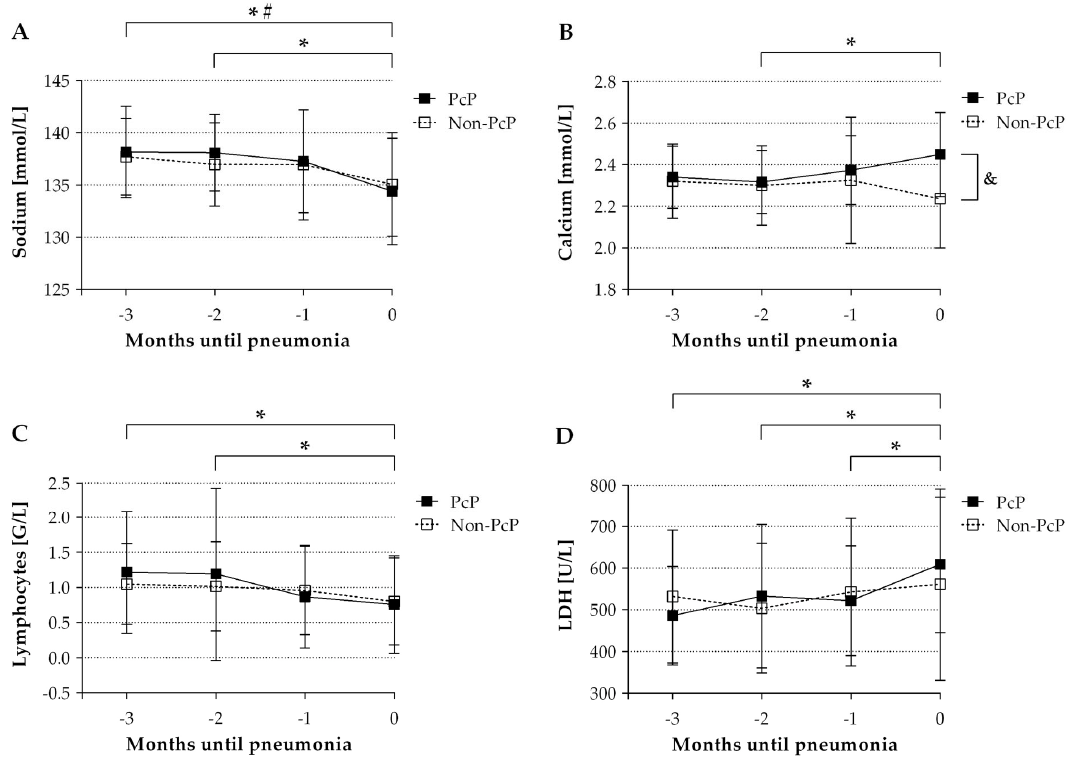
Figure 3. Course of sodium ( A ), calcium ( B ), lymphocyte count ( C ) and lactate dehydrogenase (LDH) ( D ) in renal transplant recipients (RTRs) with Pneumocystis jirovecii pneumonia (PcP) or pneumonia with other presumably bacterial pathogens (non-PcP). Analyses were made at the time of three, two and one months before diagnosis as well as at admission. Laboratory parameters were compared between the two cohorts at the same time points and within each cohort at different time points, respectively. * p < 0.05 for laboratory parameter in the PcP cohort at corresponding time points (Wilcoxon matched-pairs signed-rank); # p < 0.05 for laboratory parameter in the non-PcP cohort at corresponding time points (Wilcoxon matched-pairs signed-rank); & p < 0.05 for laboratory parameter in the PcP and non-PcP cohort at the same time point (Mann ‐ Whitney U ‐ test).